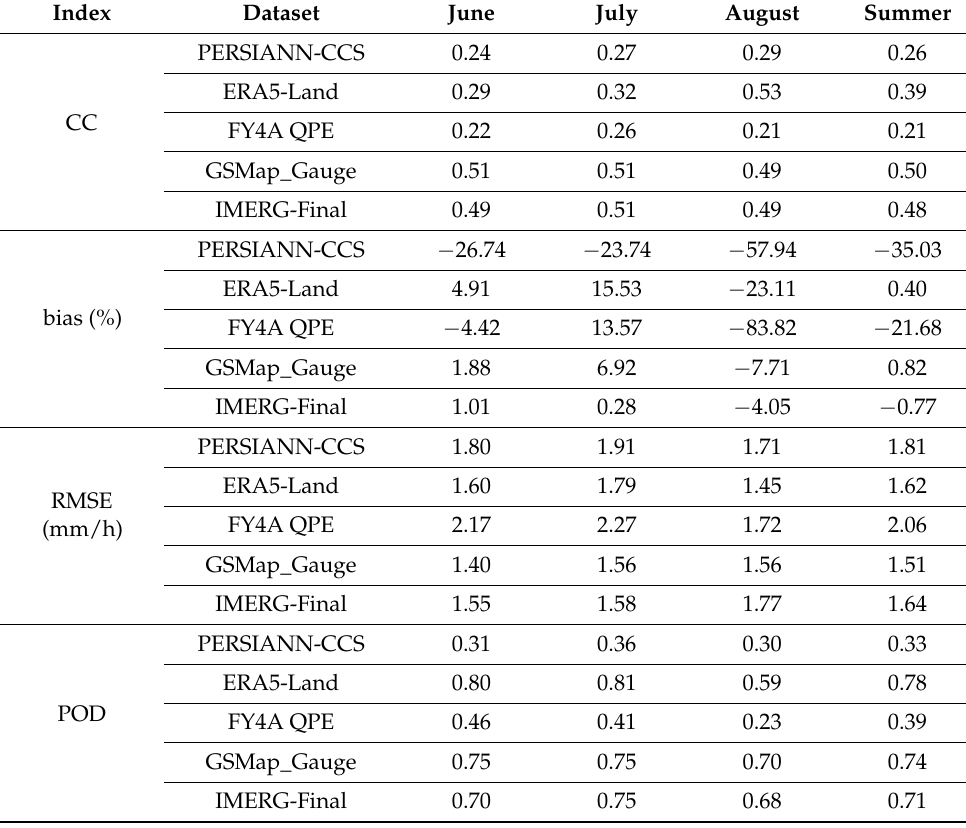
Table 3. Summaries of the performances of PERSIANN-CCS, ERA5-Land, FY4A QPE, GSMap_Gauge, and IMERG-Final, at an hourly scale, over Zhejiang in the summer of